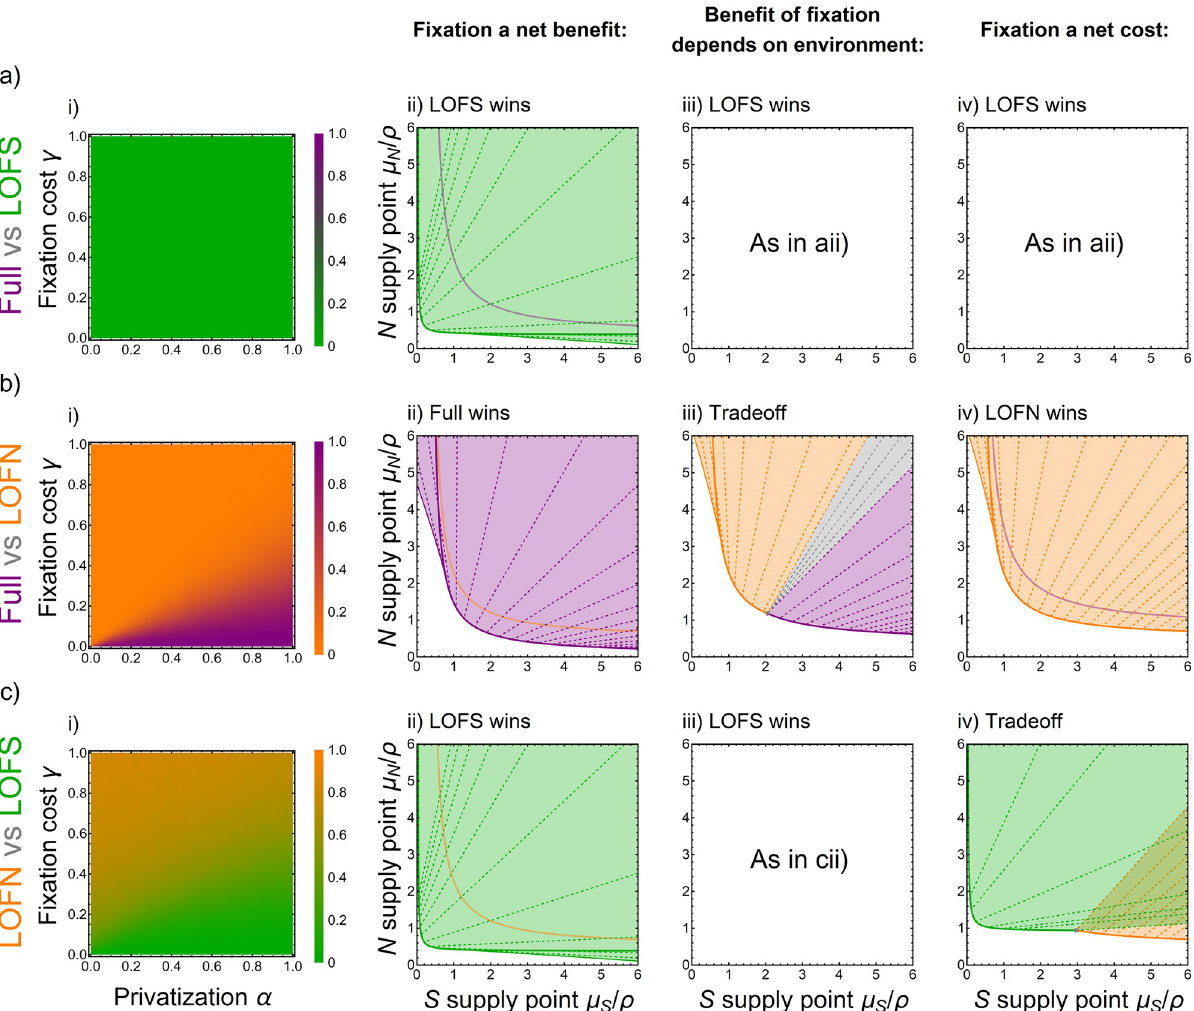
Fig 4. Sensitivity analysis and ZNGIs for the role of privatization α and cost of fixation γ for three pairwise competition scenarios (rows). The first column of each row (i) shows the probability that the second strain listed ((a) LOFS, (b) LOFN, (c) LOFS) successfully invades the first strain listed ((a,b) Full, (c) LOFN). Subsequent columns of each row plot outcomes of competition against the external environment (see Box 1 for explanation) when: (ii) fixation is beneficial even when N is in excess such that siderophores are limiting, i.e. a > g = S ð S � ; 1Þ ; (iii) fixation is beneficial when N is limiting but costly when siderophores are limiting, i.e. g = S ð S � ; 1Þ > a > g = S ð1 ; N � Þ ; (iv) fixation is costly even when N is limiting, i.e. a < g = S ð1 ; N � Þ . (a) Full vs. LOFS. i) Regardless of parameters, LOFS can successfully invade Full’s resident equilibrium ii-iv) because the ZNGI for LOFS always falls below the ZNGI for Full (siderophore production is always a net cost). (b) Full vs. LOFN. i) Full can resist invasion from LOFN if fixation is private (high α ) and not very costly to produce (low γ ). ii) If fixation is always a net benefit, then Full always wins. iii) If the benefit of fixation depends upon the environment, then either strain could win or they could coexist (with the outcome depending on environmental resource supplies). iv) If fixation is always a net cost, then LOFN always wins. (c) LOFN vs. LOFS. i) LOFS can invade LOFN if fixation is private (high α ) and not very costly to produce (low γ ). ii) If fixation is a benefit when siderophores are limiting, then LOFS outcompetes LOFN regardless of environmental conditions. iii) If the benefit of fixation depends upon the environment, then LOFS either always outcompetes LOFN (shown here) or two coexistence equilibria arise (shown in S5 Fig), with the latter case arising if fixation is more costly than siderophore production moving away from S � . iv) If fixation is costly when nitrogen is limiting, then LOFN wins in N-limited regimes and LOFS wins in siderophore-limited regimes, with a priority effect in regions of